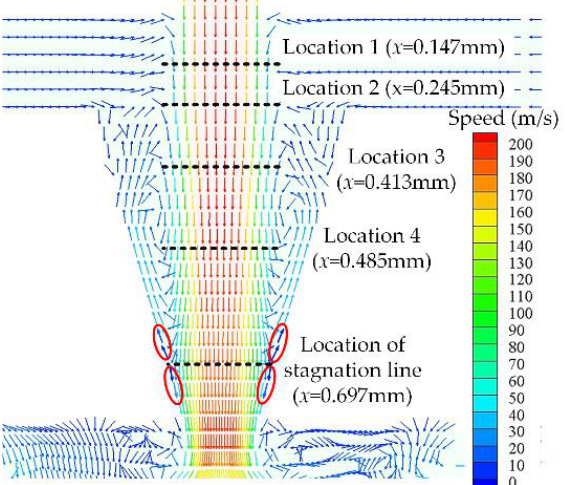
Figure 15. Locations for comparisons in the mean section of the deflector.